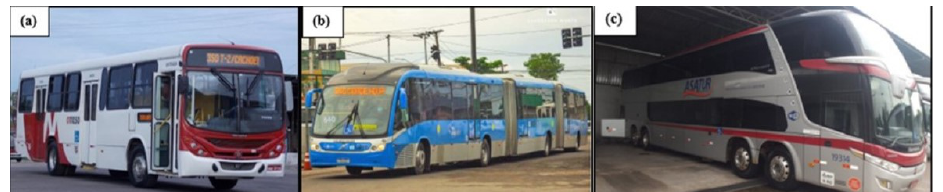
Figure 1. Illustrative images of the bus models used in this research. ( a ) Light Diesel Engine (LDV) for Urban Passenger Transport, ( b ) Heavy articulated bus (HDV) for urban passenger transport, ( c ) Heavy passenger intercity transport bus (HDV).